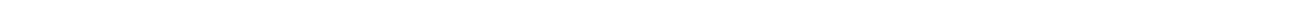
Fig. 4 NOTCH activation induces formation of arterial-type HE cells. a Flow cytometric analysis of DLL4 and CD73 expression following culture of D4 HE for 1 or 2 days in the presence of DAPT or DLL1-Fc. NOTCH activation on D4 HE speci fi cally increases the CD144 + CD73 − DLL4 + population. b Frequencies of DLL4 + cells in hemogenic (CD73 − ) and non-hemogenic fractions of endothelium following 1 and 2 days of culture of D4 HE in the presence of DAPT or DLL1-Fc. Results are mean ± s.e.m. for three independent experiments; two-way ANOVA Bonferroni post-hoc test, * p < 0.05, ** p < 0.01, *** p < 0.001. c Flow cytometric analysis of Runx1 + 23 enhancer activity following 1 day of culture of D4 HE in presence of DAPT or DLL1-Fc. Runx1 + 23 enhancer activity is limited to the CD144 + CD73 − DLL4 + population. Representative contour plots from two independent experiments are shown. d Schematic diagram of FACS isolation of endothelial subpopulations formed on D5 of differentiation. e qPCR analysis of arterial ( NOTCH1, DLL4, EFNB2, HEY2, SOX17, CXCR4 ), venous ( NR2F2 ), hematopoietic ( MYB, GATA2 ), and mesodermal ( HAND1) genes in D4 HE and D5 endothelial subpopulations. Results are mean ± s.e.m. for three independent experiments; one-way ANOVA Bonferroni post-hoc test, * p < 0.05, ** p < 0.01, *** p <